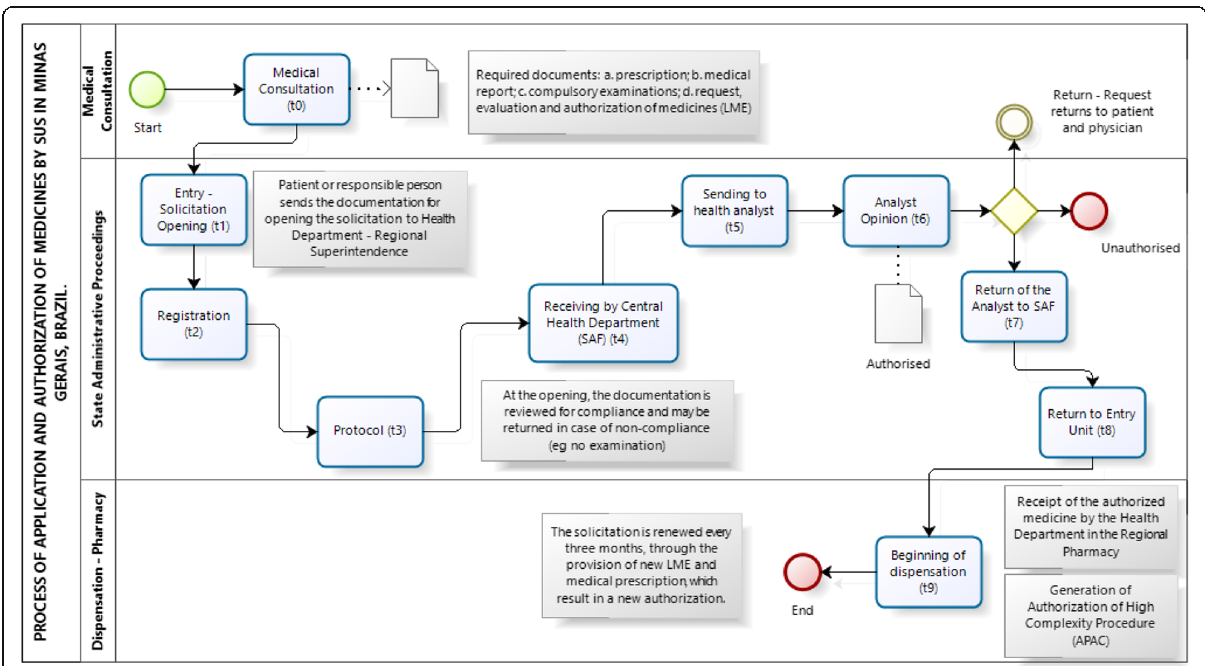
Fig. 1 Process with steps for the request and supplying of medications at SCPA-SUS. Legend: LME = Appraisal for Request, Evaluation, and Authorization of Medications (standardize